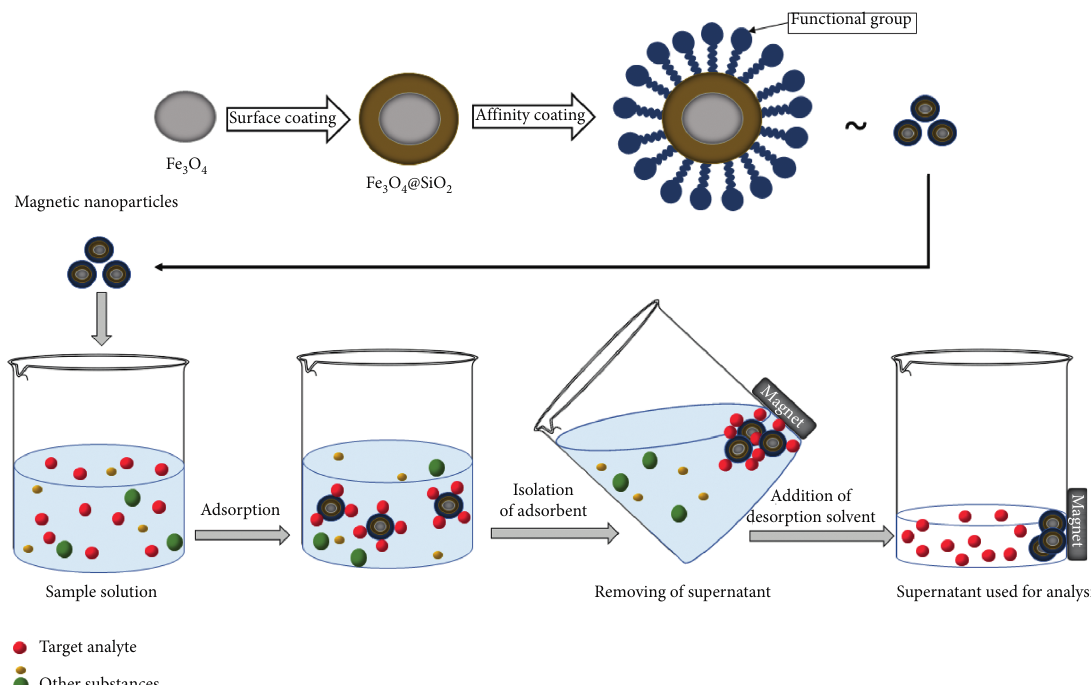
Figure 2: Schematic representation for the synthesis of magnetic nanoparticles (according to Liu et al. [24]) and their application in MSPE of the target